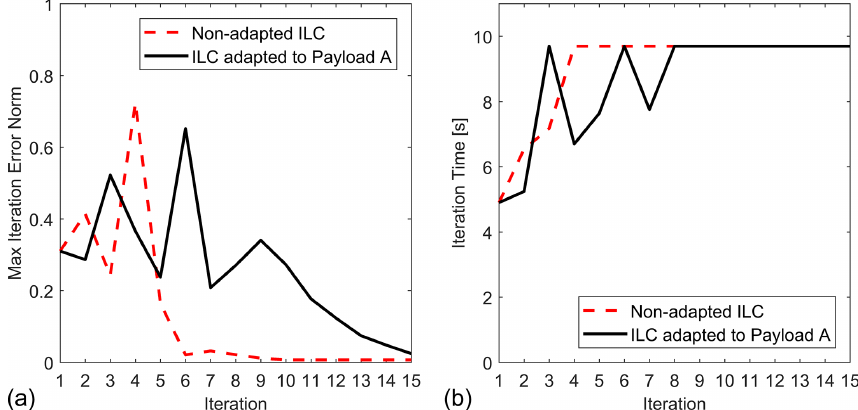
Figure 8. Convergence comparison of the ILC process for Trajectory E with Payload B for non-adapted ILC and ILC adapted to Payload A: (a) maximum tracking error and (b) iteration